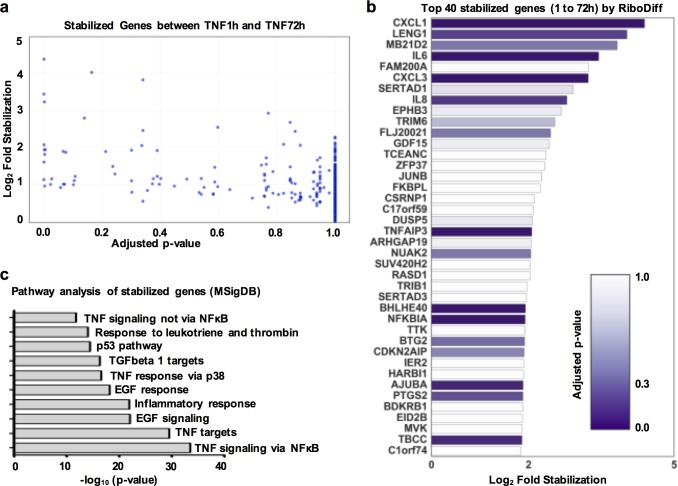
Genome-wide identification of transcripts stabilized by TNF in RA FLS.Two biologic replicates of RA FLS (derived from two different RA patients) were exposed to a single dose of TNF (10 ng/ml) for 1 or 72h. Subsequently, Act D was added for 3h and gene expression was measured by RNA sequencing. The degree of TNF-induced mRNA stabilization was calculated as the log2 difference of TNF+Act D/TNF ratio between 1 and 72h of TNF stimulation and the adjusted p values of TNF-induced stabilization were calculated by RiboDiff. (a), Scatter-plot of the genes displaying TNF-induced mRNA stabilization comparing the degree of mRNA stabilization (y axis) to the adjusted p values of the stabilizing effect of TNF (x-axis). (b), The top 40 genes displaying the highest TNF-induced mRNA stabilization ranked by the degree of stabilization. (c), Enriched biological processes identified by GSEA/MSigDB pathway analysis of the top 10% of the genes (n = 593) displaying the highest degree of TNF-induced mRNA stabilization.